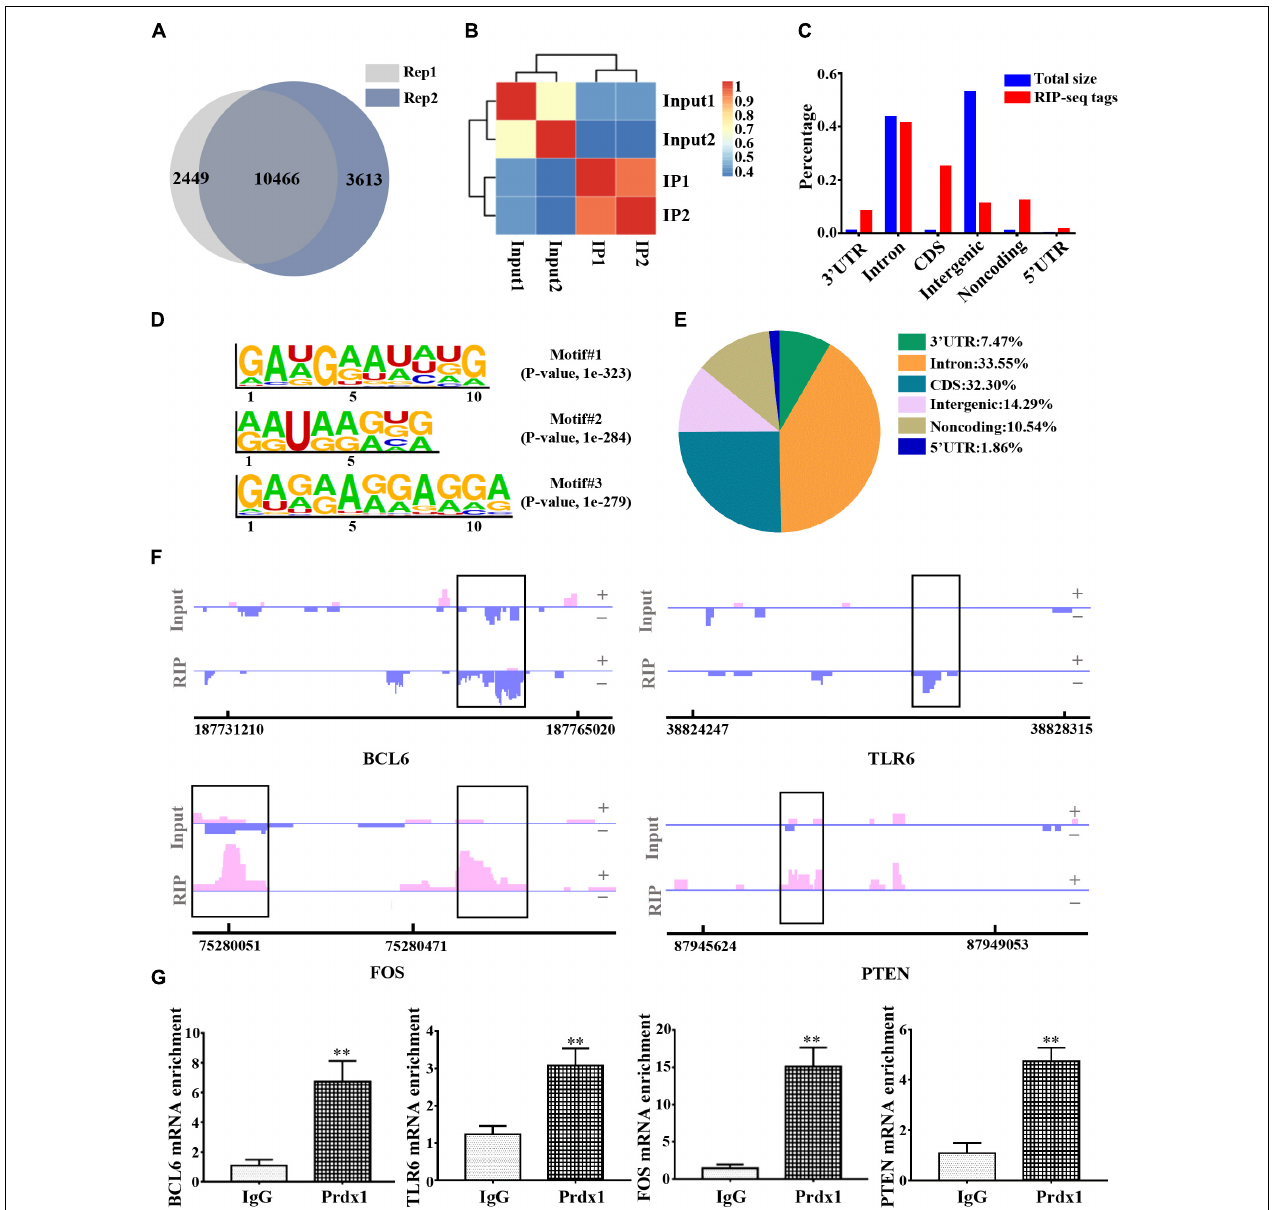
FIGURE 5 | The genome-wide landscape of Prdx1 binding sites on RNA. (A) Venn diagram of Prdx1 RIP-seq genes from two biological replicates. (B) Heat map showing the correlation coefficient of two biological replicates. (C) The Prdx1 RIP-seq peaks are predominantly enriched in the CDS region, the 3 (cid:48) UTR and the 5 (cid:48) UTR. All RIP-seq peaks were classified according to their distribution on the RNA elements and compared to the genomic background. (D) De novo motif analysis identified GA repeat and GA-enriched sequences as Prdx1 binding motifs. (E) Prdx1 RIP-seq peak distribution proportion. (F) Prdx1 RIP-seq peaks are shown as track signals. The peak area is indicated by the black frame. (G) RIP-qPCR analysis of Prdx1 binding RNAs, IgG RIP was negative RIP control (BCL6: F = 3.745, t = –6.708, ∗∗ P < 0.01 versus IgG, n = 3; TLR6: F = 1.668, t = –7.065, ∗∗ P < 0.01 versus IgG, n = 3; FOS: F = 5.224, t = –10.432, ∗∗ P < 0.01 versus IgG, n = 3; PTEN: F = 0.000, t = –6.998, ∗∗ P < 0.01 versus IgG, n =